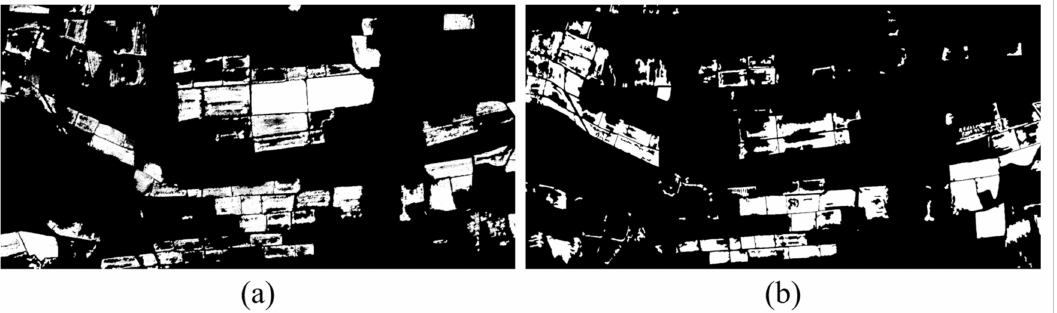
Figure 5. Ground truth of rich lodging portion in white: ( a ) 2017 image and ( b ) 2019